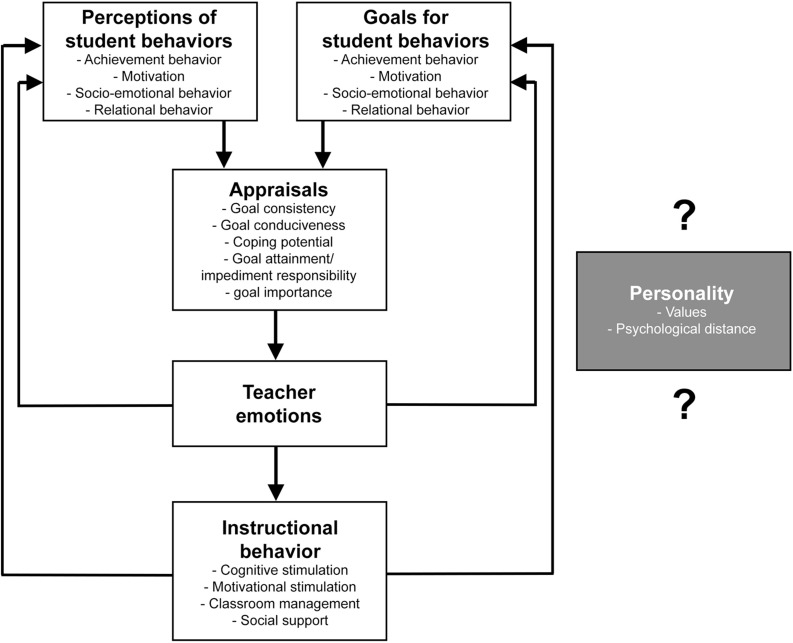
Overview of the reciprocal model on causes and effects of teacher emotions (adapted from Frenzel, 2014) in white rectangles and personality as a missing concept in the gray rectangle.